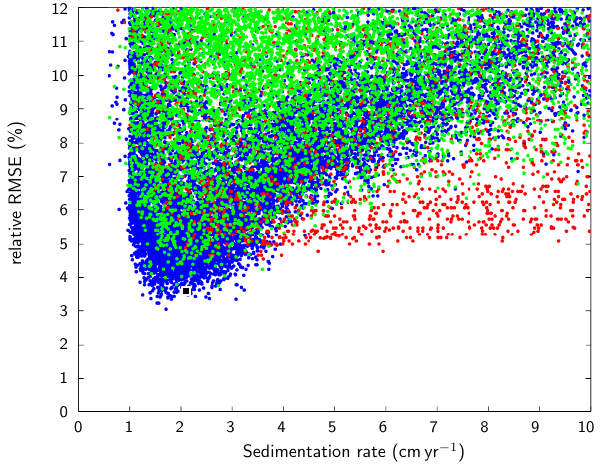
Fig. 7. Model error in a Monte Carlo parameter variation, projected to the effect of variations in the sedimentation rate. The dots shows the relative root mean squared error (relative RMSE) of the pore water profile of SO 4 ( blue ), NH 4 ( red ), and composite of both pro- files ( green ). The black square denotes the best fitting run (standard calibration) given in Table 1 and shown in Fig.